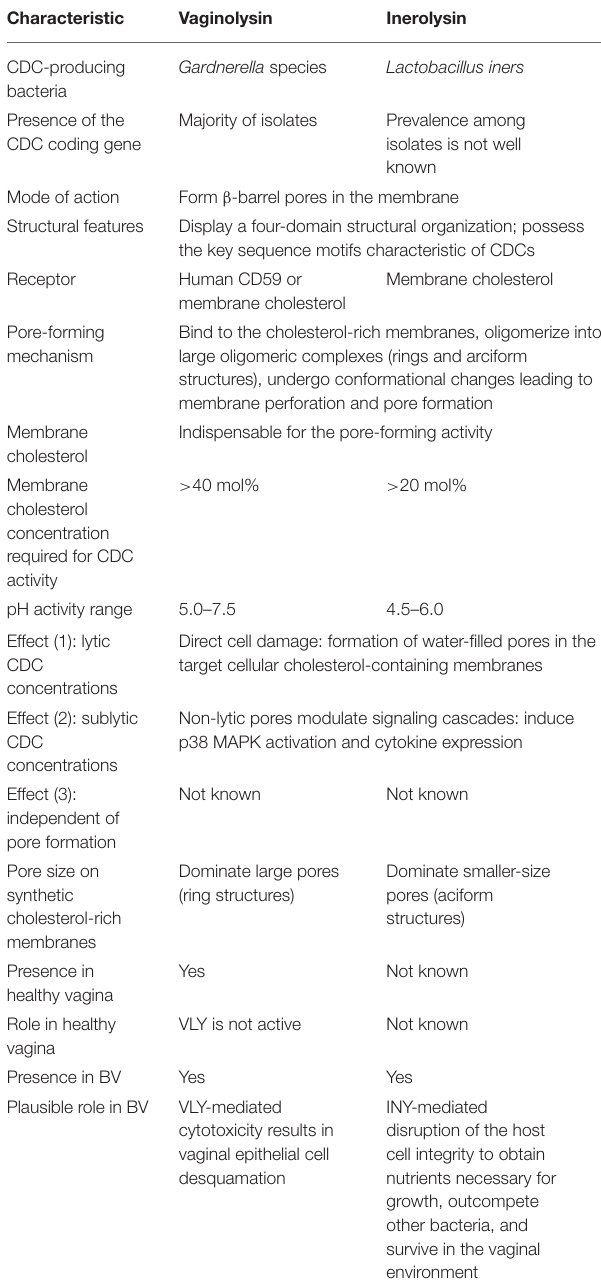
TABLE 1 | Summary of vaginolysin and inerolysin